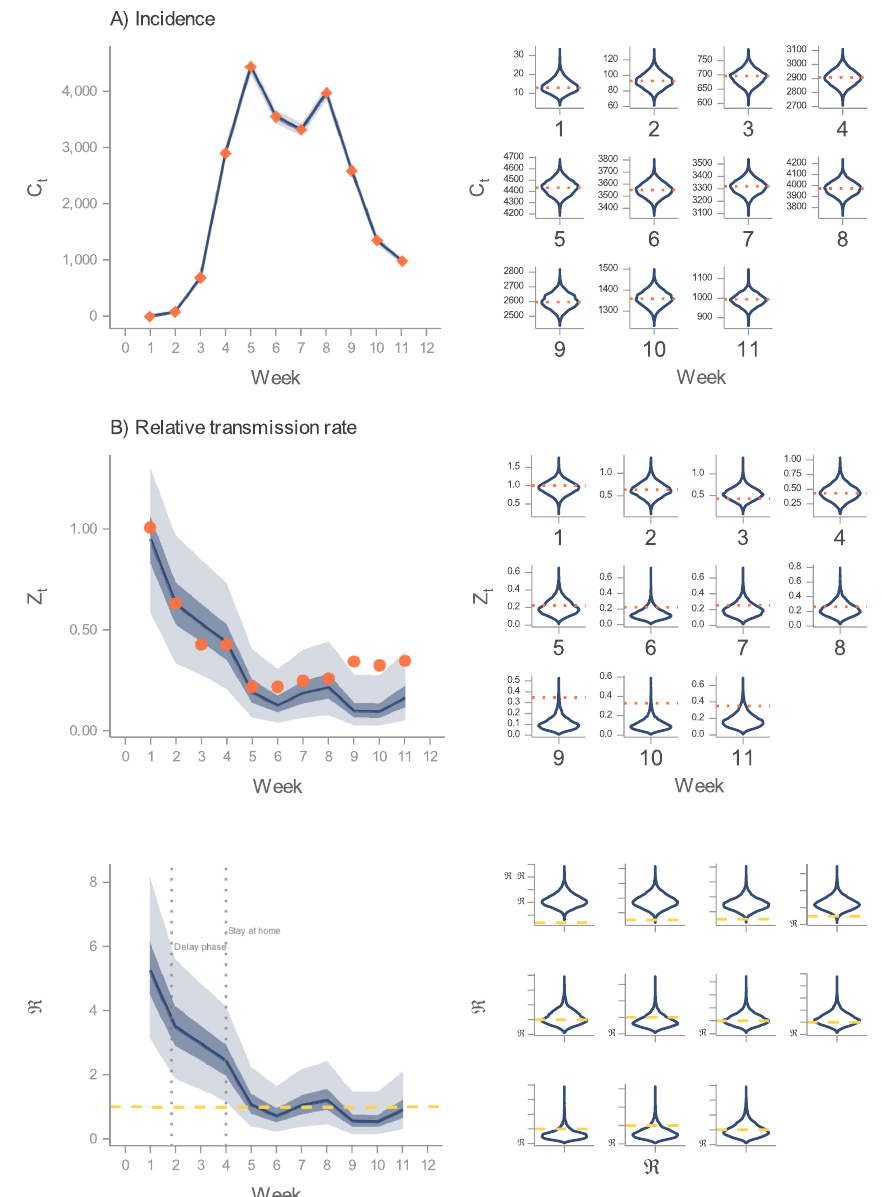
Fig 4. Inference on DGP1. In these three figures, the predicted values stem from DGP1’s filtering distribution. Further, in the LHS, the solid line indicates the median, and the darker and lighter ribbons represent the 50% and 95% CI, respectively. (A) Comparison between the predicted incidence (solid line and ribbons in the LHS; violin plots in the RHS) and weekly detected cases from Ireland’s first COVID-19 wave (rhombi in the LHS; horizontal dotted lines in the RHS). (B) Comparison between the predicted relative transmission rate (solid line and ribbons in the LHS; violin plots in the RHS) compared to Apple’s mobility indexes in Ireland (points in the LHS; horizontal dotted lines in the RHS). (C) Predicted effective reproduction number (solid line and ribbons in the LHS; violin plots in the RHS). Horizontal dashed lines denote the epidemics threshold.